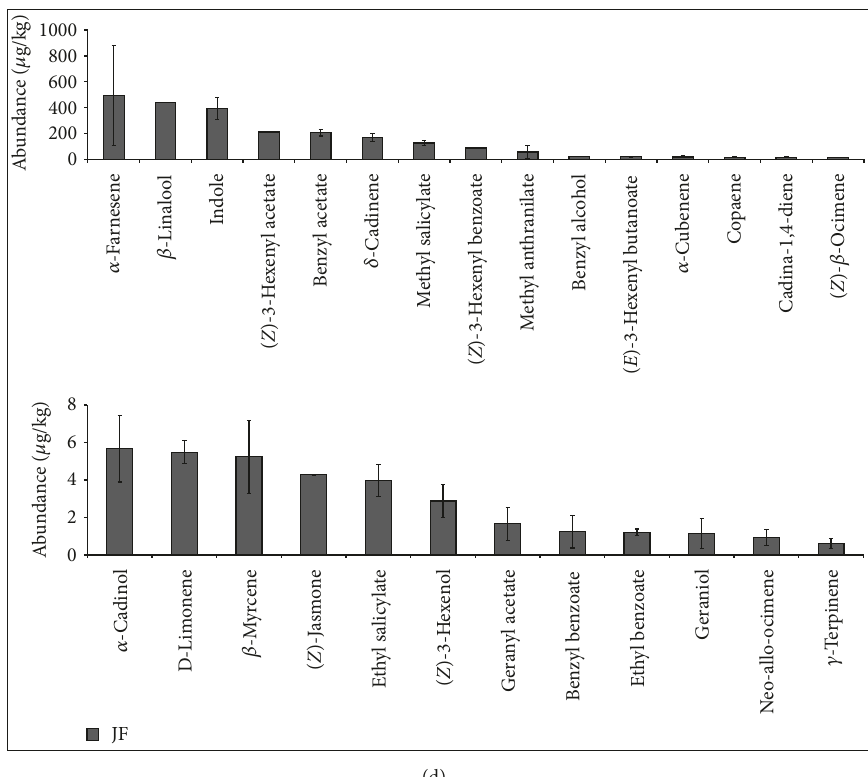
Figure 3: Enhanced floral volatiles in scented tea probably due to tea adsorption. (a) Volatiles with high abundances present in the scented tea; (b) volatiles with less abundances present in the scented tea; (c) volatiles present in scented tea only. (d) Volatiles present in the headspace of fresh jasmine flowers. ST: scented green tea infusion; NT: nonscented tea infusion; JF: jasmine flower; ND: not detected. Duncan’s new multiple range test was performed and the columns labeled with the same letter within the same compound had no significant difference among the tested samples, 𝑃 < 0.05 . NS: no significant difference detected.